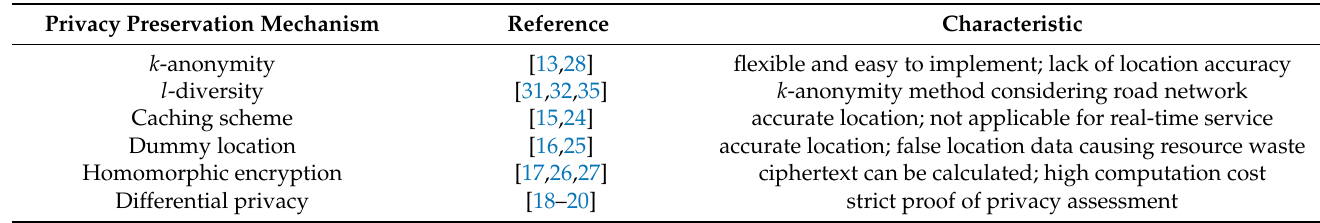
Table 1. Summary of Privacy Preserving Schemes that address Location Privacy.